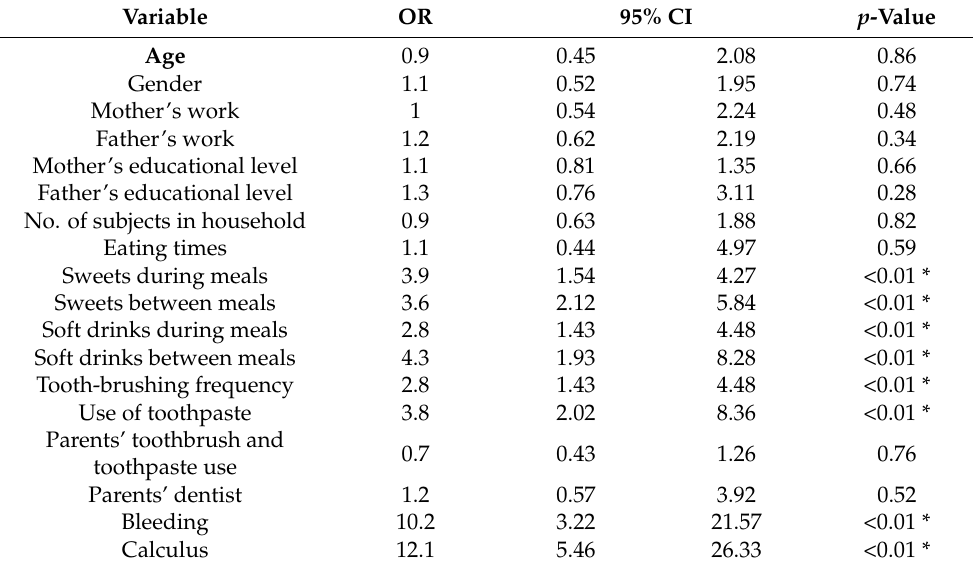
Table 2. Multivariate model of the associations between caries and the explanatory